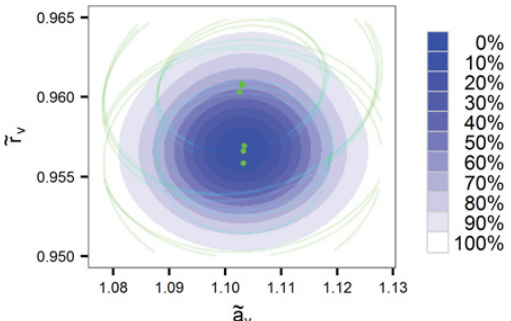
Figure 2. Sampling distribution after ten iterations. The green ellipses indicate the components of the sampling distribution with a proportion greater than one